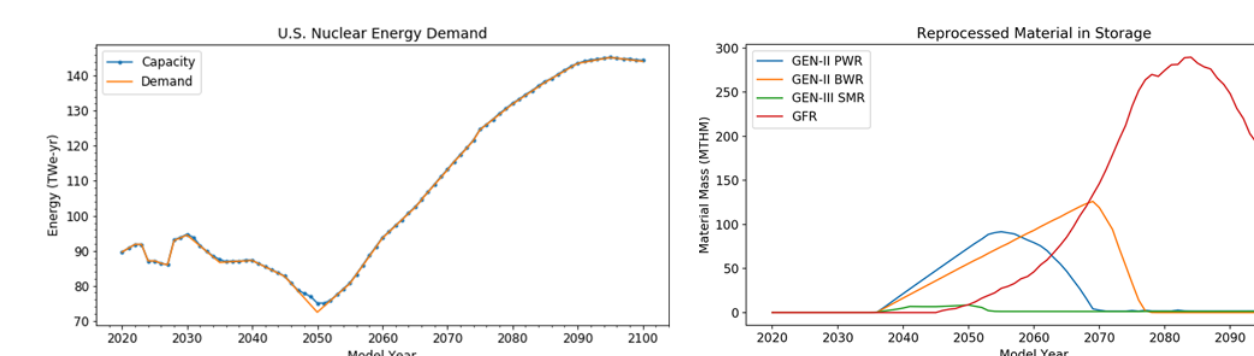
Fig. 1. Base scenario energy production by reactor type.